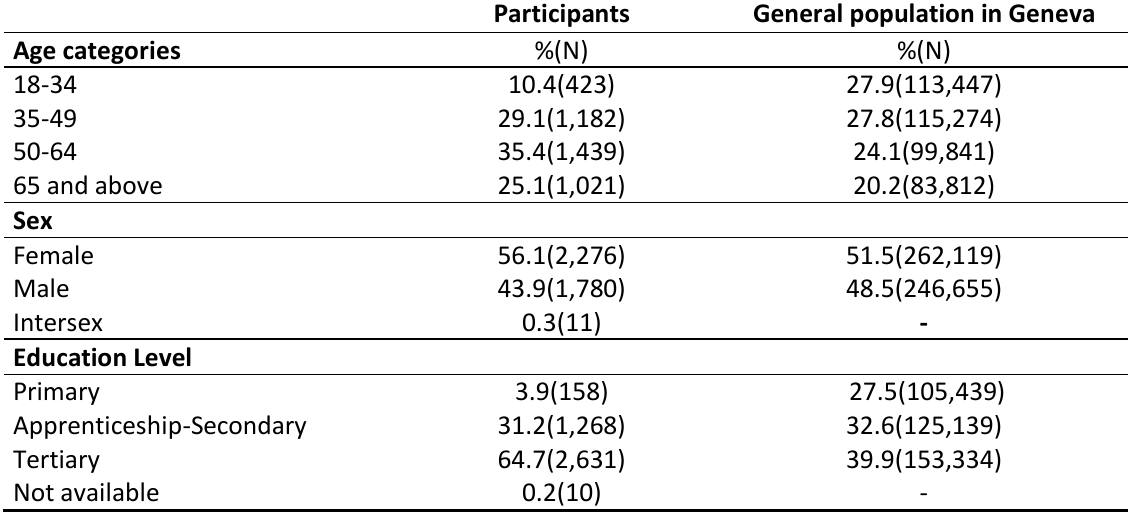
Table S2. Characteristics of participants and the general population in Geneva